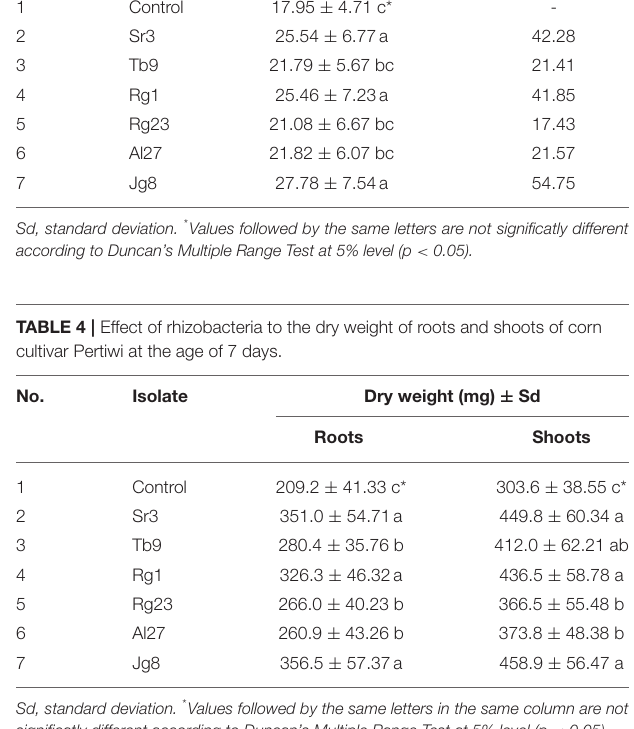
( Table 5 ). Based on phylogenetic tree analysis, isolate Sr3 is in the same clade with Brevibacillus invocatus ( Figure 3